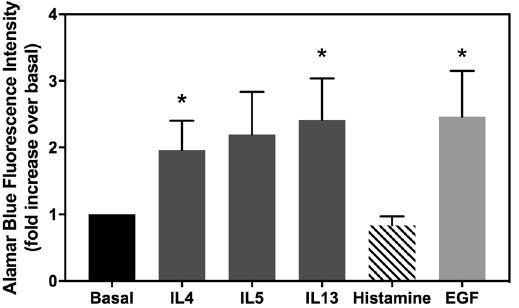
Figure 10. Effect of cytokines on conjunctival goblet cell proliferation. Goblet cells were incubated for 24 h with 10 ng/ml IL4, 10 ng/ml IL5, 10 ng/ml IL13, 10 − 5 M histamine, or 10 − 7 M EGF and cell proliferation measured. Data are mean ± SEM from seven independent experiments. * ≤